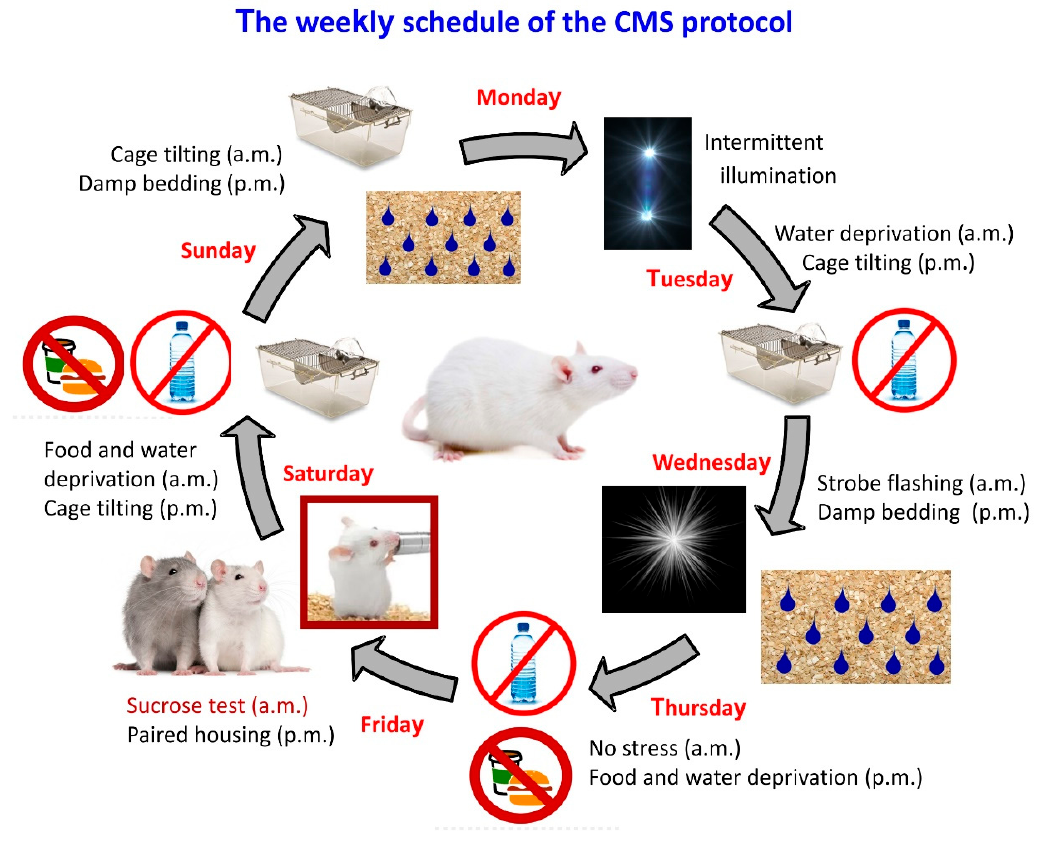
Figure 1. The weekly protocol of the chronic mild stress (CMS) treatment. Adult male Wistar rats are subjected every day to a different micro-stressor lasting for 10–14 h. Intermittent illumination: lights on and off every 2 hours; Cage tilting into a 45° position; Strobe flashing: stroboscopic lightning; Damp bedding: pouring water into the cage to damp the beddings; Paired housing: pairing two rats by having an unfamiliar partner at each grouping session. This weekly schedule is typically repeated over a period of 4–8 weeks.